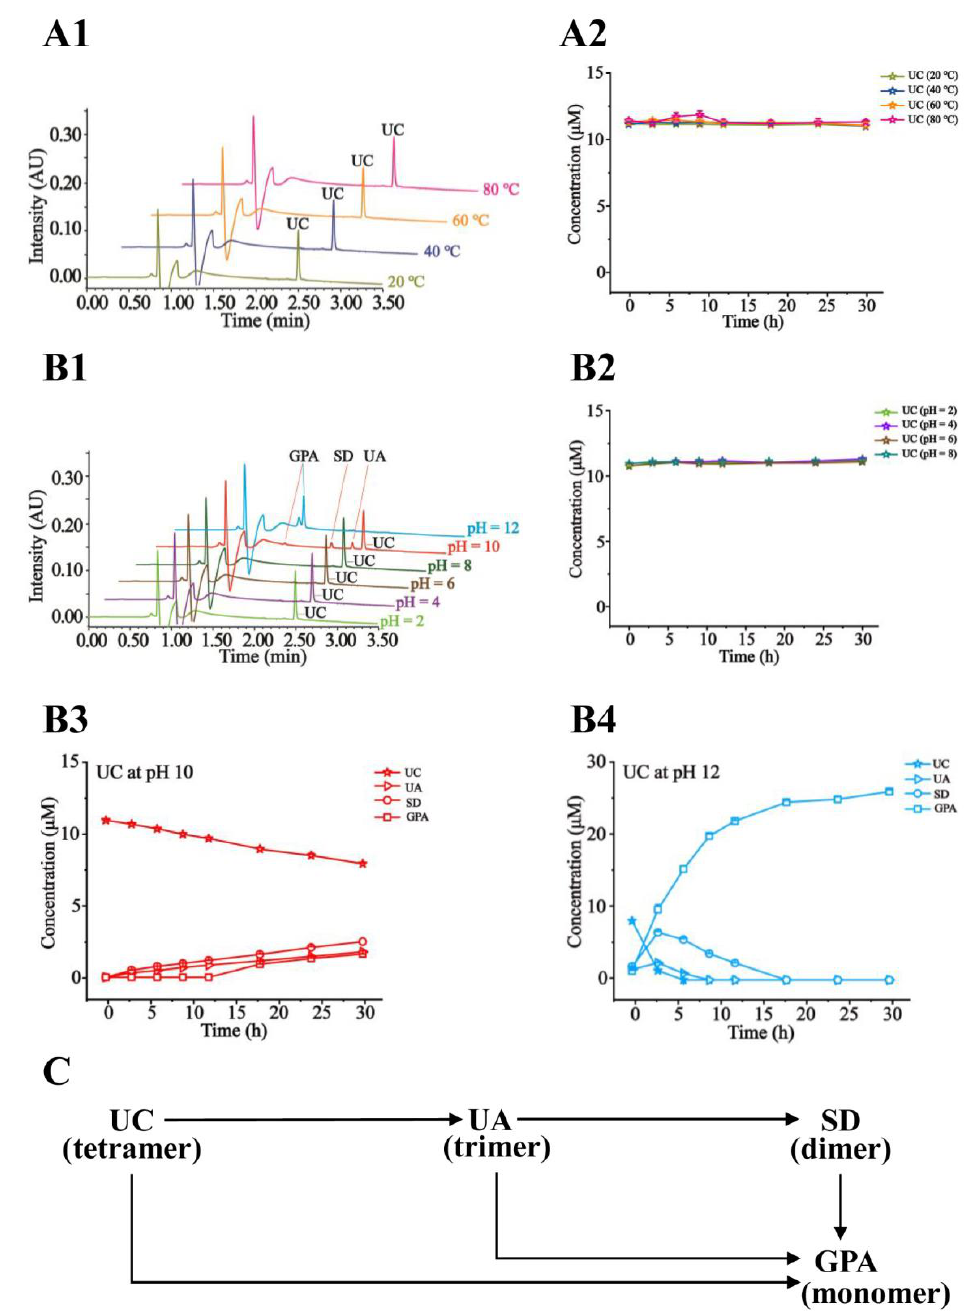
Figure 4. Representative chromatograms of UC in the tested solution exposed to different tempera- tures ( A1 ) and pH levels ( B1 ) after 24 h; Time–concentration curves of UC at different temperatures ( A2 ) and pH 2~8 ( B2 ); Time–concentration curves of UC and the degraded products at pH 10 ( B3 ) and pH 12 ( B4 ); The proposed degradation pathways of UC ( C ).